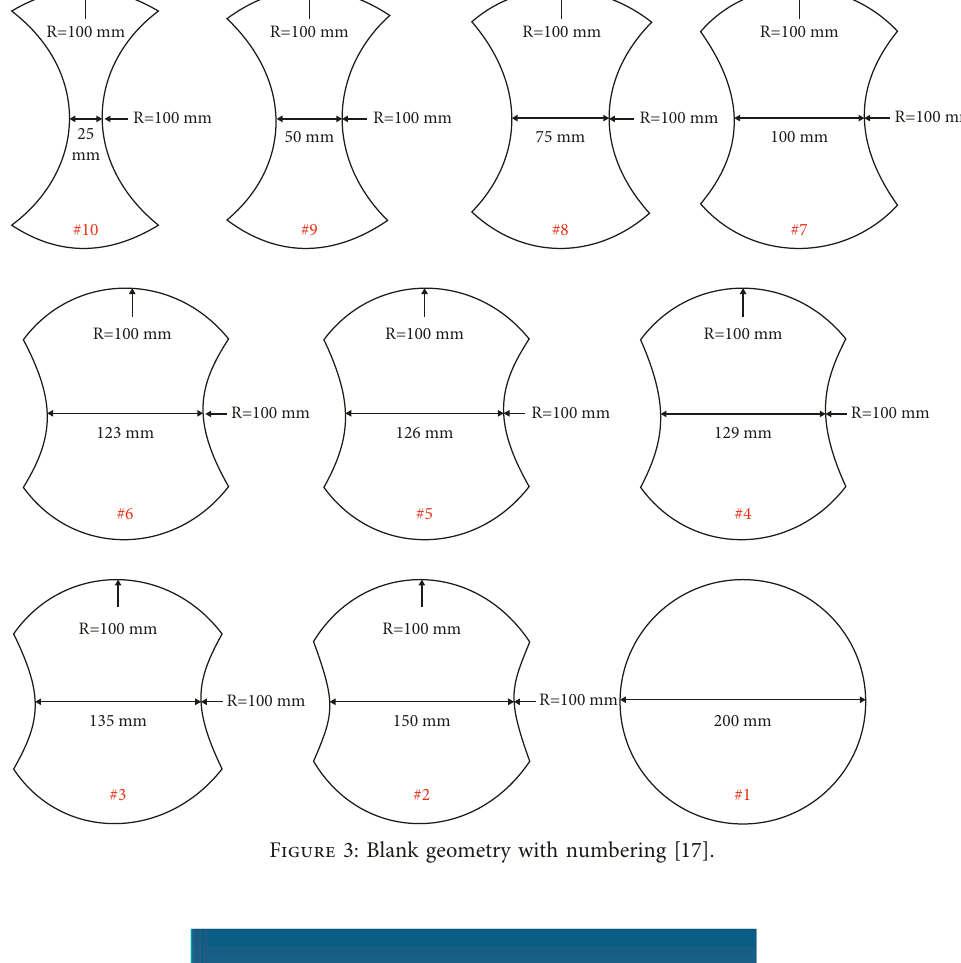
Figure 3: Blank geometry with numbering [17].